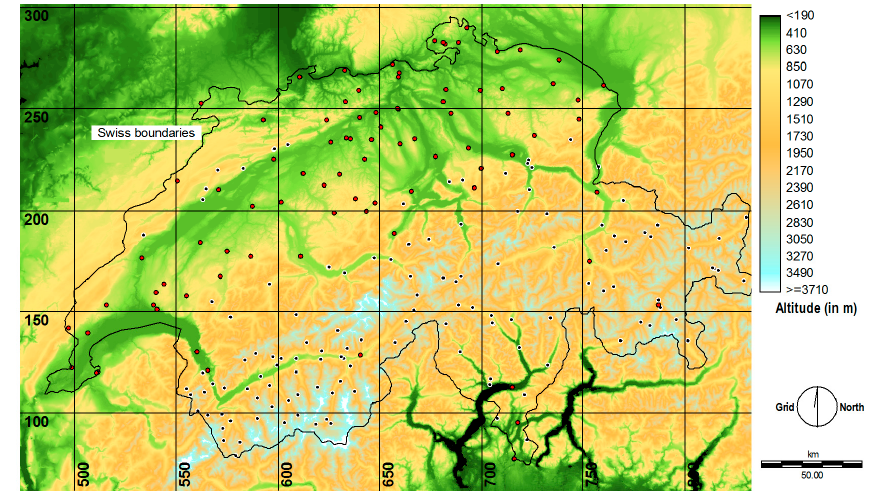
Figure 1. Digital Elevation Map of the (360 × 240 km 2 ) Alpine study area centered around Switzerland. The black (red) dots show the locations of the “complex (“non-complex) terrain” rain gauges (for more details see Section 4 and [25], Section 2.d, page 1253). The displayed Cartesian grid is coincident with the Swiss national coordinate system (CH1903), which results from a conformal mapping from the Bessel reference ellipsoid onto a longitudinal cylinder. The Swiss coordinates of the four corners (bottom-left, top-left, top-right, bottom-right) are: (473; 62), (473; 302); (833; 302), (833; 62). The corresponding Lat-Long coordinates (WGS84 datum) are: (45.6978°; 5.8083°), (47.8561°; 5.7416°), (47.8269°; 10.5509°), (45.6698°; 10.8083°).